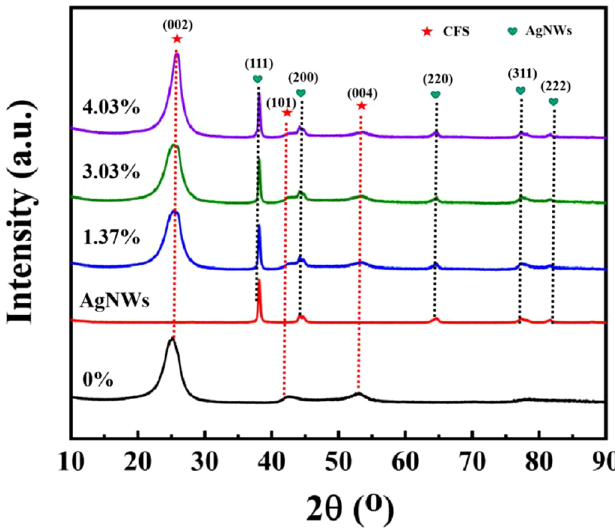
Fig. 2. XRD patterns of CFS and CFS/AgNWs composites with different content of AgNWs.